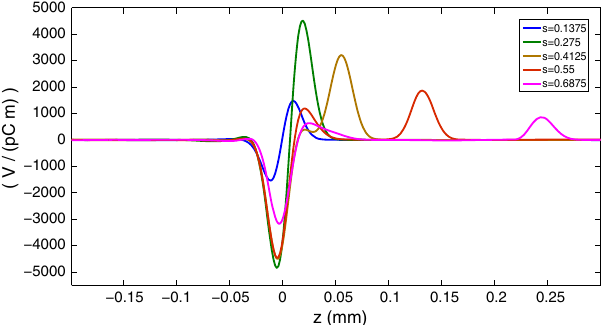
FIG. 22. Evolution of the wakefield W ð z; s Þ of a Gaussian bunch versus s in a bend of length s